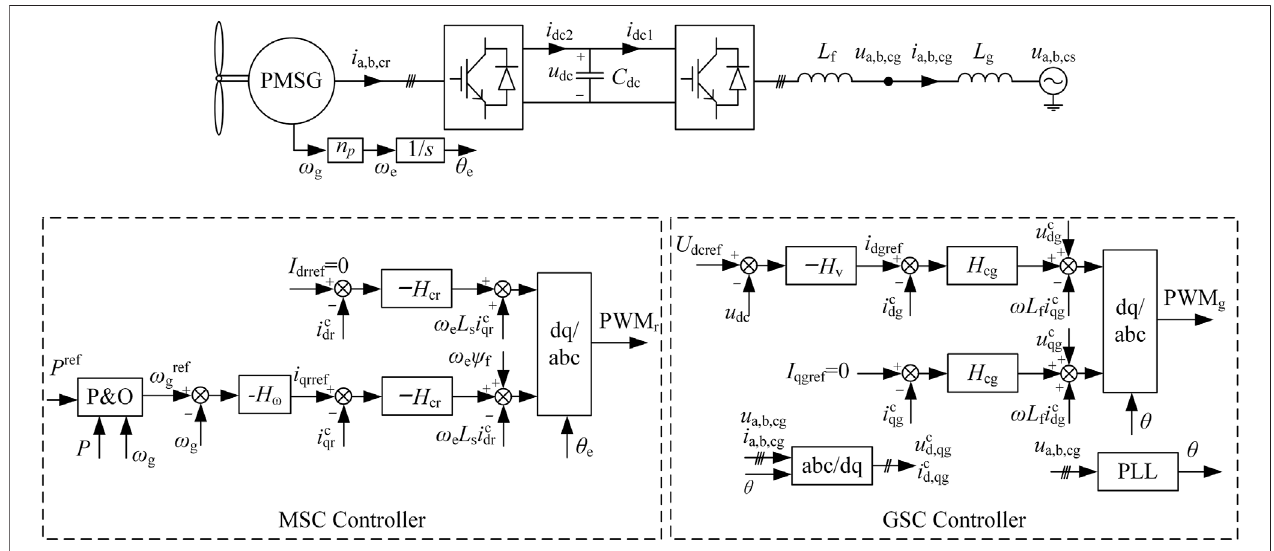
FIGURE 3 | Structure and control strategy of the grid-connected